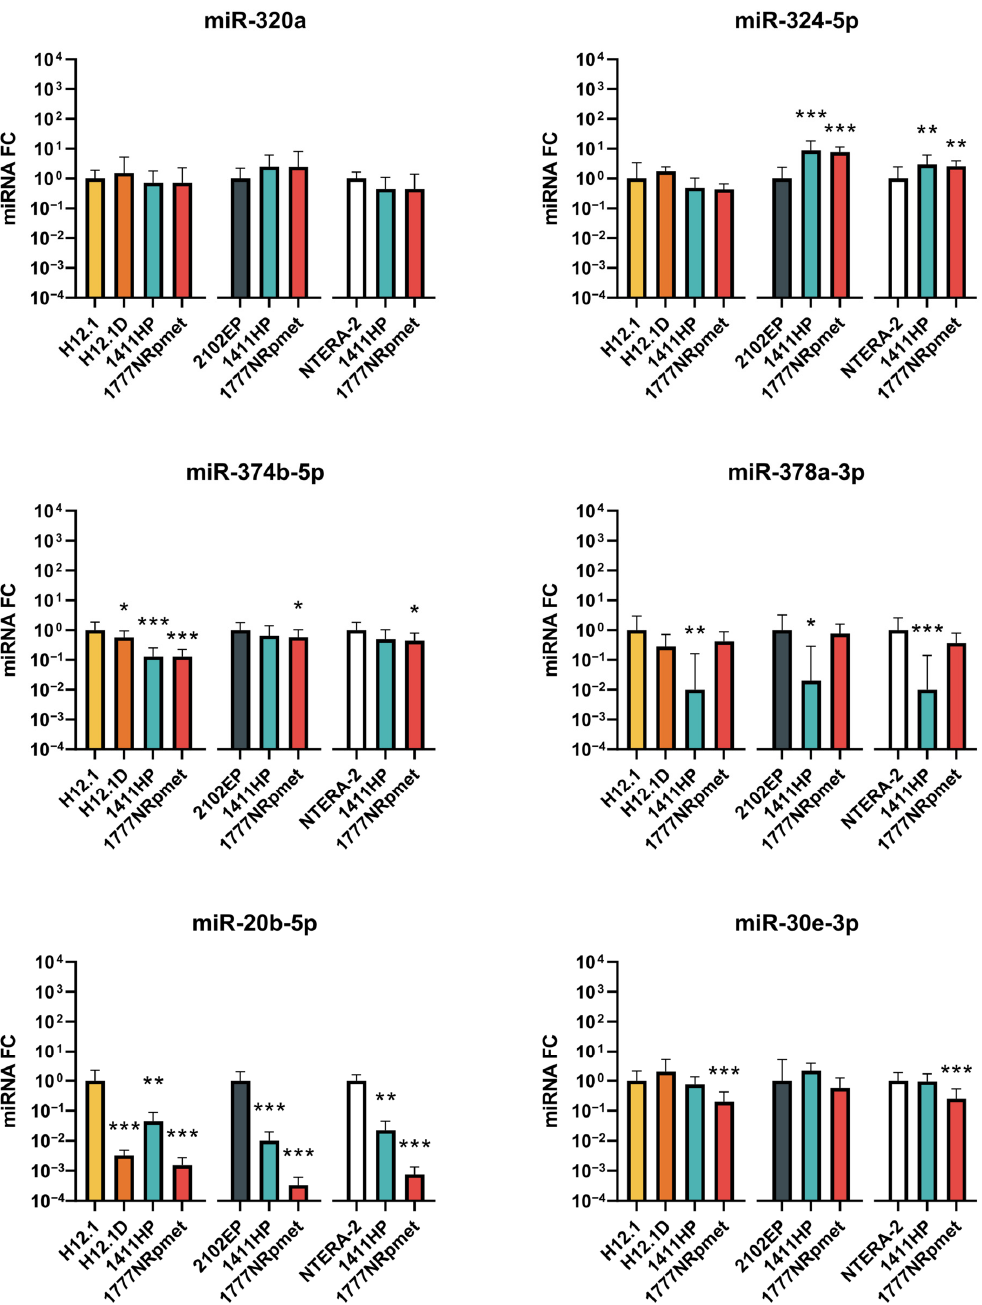
Figure 4. Expression changes of six candidate miRNAs that were identified as down-regulated in miRNA expression array. CDDP-resistant (H12.1D, 1411HP and 1777NRpmet) and -sensitive (H12.1, 2102EP and NTERA-2) TGCT cell lines were compared. CDDP-resistant cell line H12.1D was compared only with CDDP-sensitive cell line H12.1, as it represents its isogenic pair. Data are presented as mean FC (2 − ∆∆ Ct ) of CDDP-resistant vs. -sensitive TGCT cell lines from three technical and three biological replicates. Error bars represent upper and lower limits of expression (2 − ∆∆ Ct ± SD ∆ Ct ). * p ≤ 0.05, ** p ≤ 0.01, *** p ≤